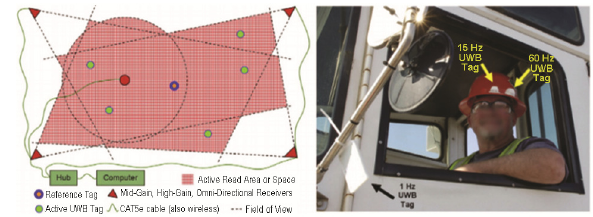
Fig. 4. Triangulation of UwB tags using UwB receivers that overlap the coverage area/space inside a lay-down yard (Cheng et al. 2011)